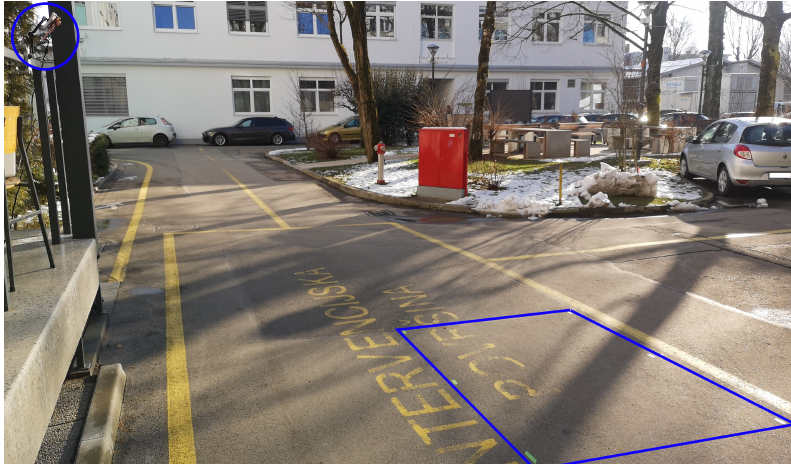
Figure 12. Photo of experimental